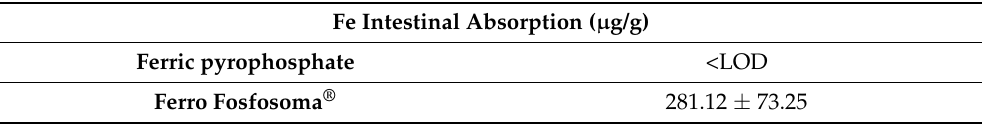
Table 4. Intracellular Fe levels in intestinal epithelial cells (Caco-2) at the end of the 3 h incubation with bioaccessible fractions of the two Fe formulations. Results are expressed as mean ± standard deviation. LOD 0.22 µ